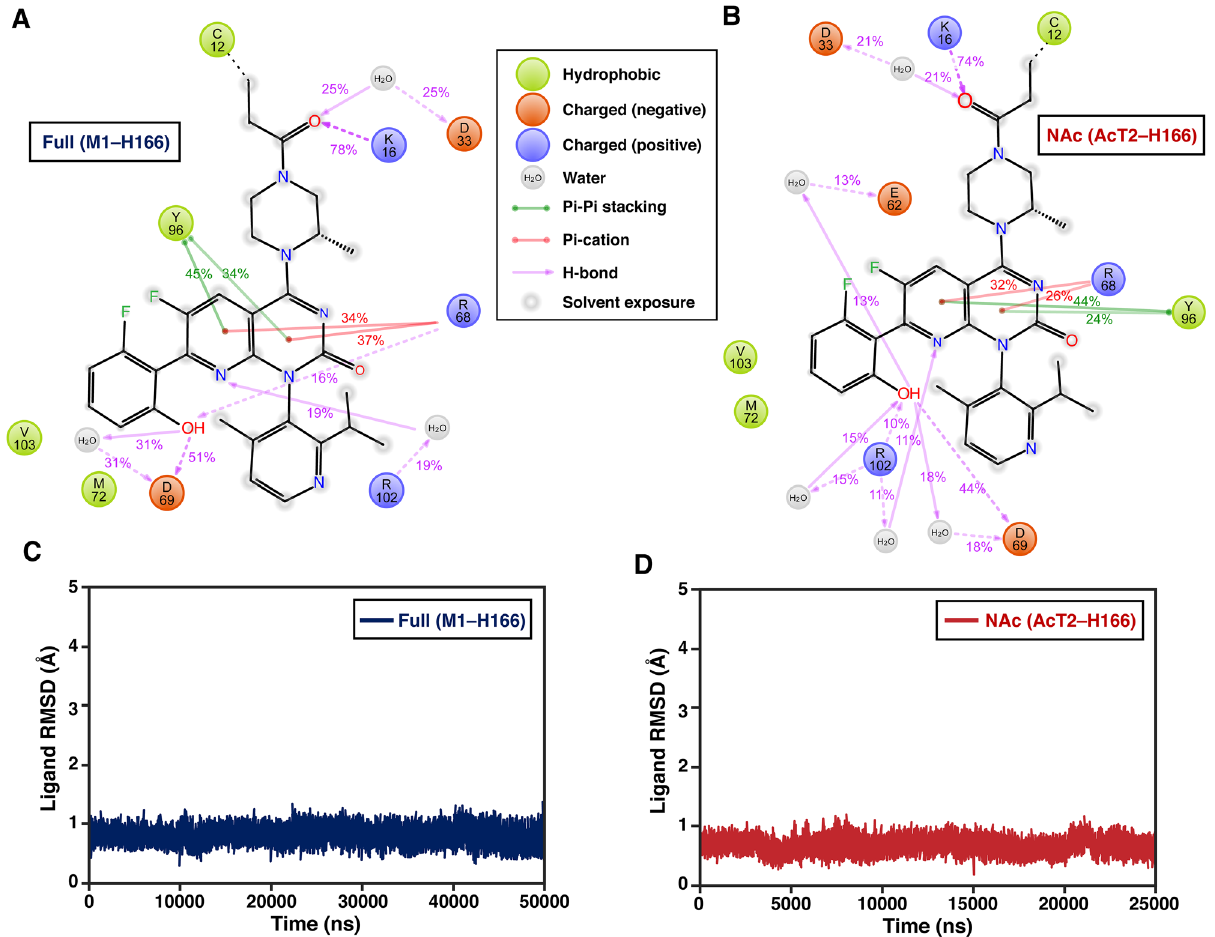
Figure 2. KRAS(G12C)–AMG 510 interactions in the MD simulations. ( A ) Observed KRAS(G12C)–AMG 510 interactions with the simulations of Full (M1–H166) systems (total of 50 μs simulation data). ( B ) Observed KRAS(G12C)–AMG 510 interactions with the simulations of NAc (AcT2–H166) systems (total of 25 μs simulation data). Interactions that occur more than 10% of the simulation time are displayed. ( C ) Ligand root-mean-square deviation (RMSD) in the simulations of Full (M1–H166) systems. ( D ) Ligand RMSD in the simulations of NAc (AcT2–H166)